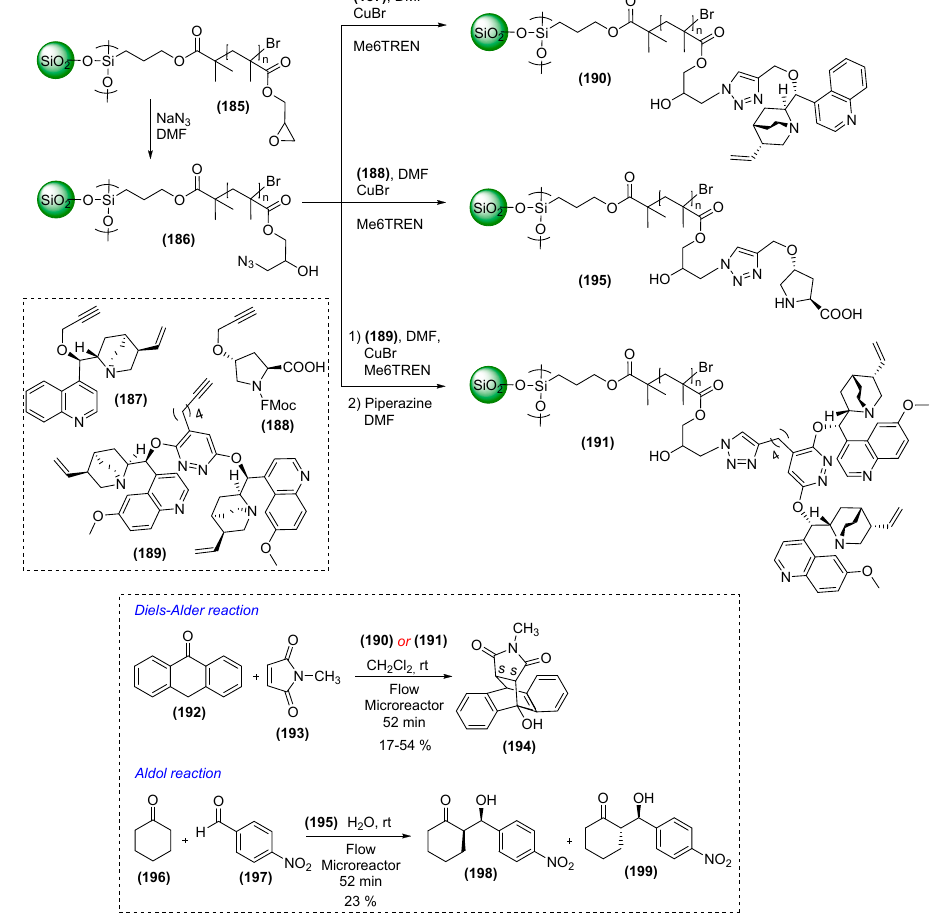
Scheme 35. Synthesis and application of polymer-supported organocatalysts.